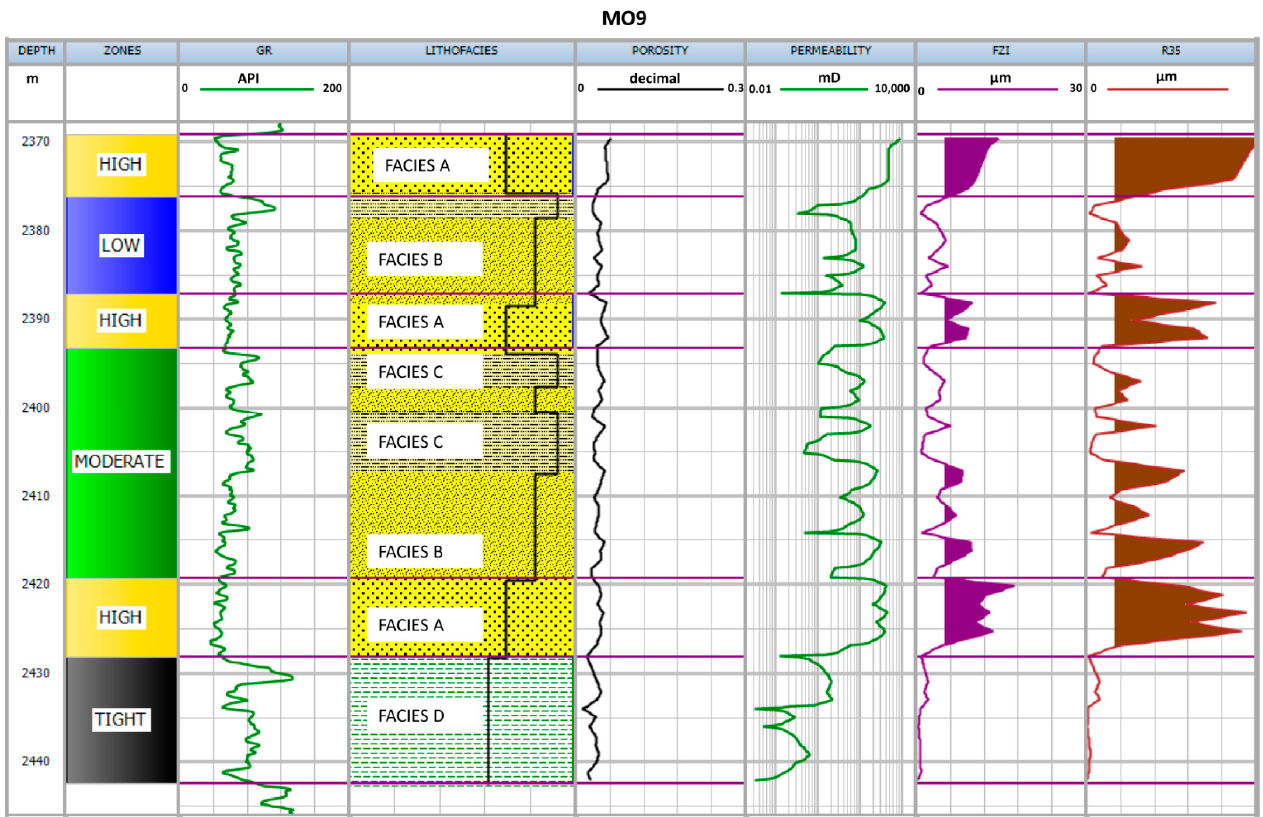
12 of 17 Figure 7. Results of well MO8 showing flow zones in track 2, gamma ray log in track 3, facies in track 4, porosity in track 5, permeability in track 6, FZI in track 7 and r35 in track 8. Six flow zones were identified in well MO9 (Figure 8). At the top of the reservoir is the high flow zone (2369.2–2376.2 m), Low (2376.2–2387.2 m), High (2387.3–2393.3 m), Moderate (2387.3–2419.3 m), High (2419.3–2428.2 m) and Tight (2428.2–2442.4 m) at the bottom of the reservoir. The high flow zones are generally associated with facies A. The high flow zone at the top of the reservoir is the best. It contributes 14% and 44% to storage and flow capacities, while the combinations of the other two high flow zones, the low zone and the moderate zone, contribute 70% and 55% to storage and flow capacities. Con ‐ versely, the tight flow zone interpreted as the lowest rock quality is associated with facies D, mainly silt and claystone ranked as an impervious reservoir rock type with 6% storage and 1% flow capacities. Flow zones are correlated to determine the lateral extent of the flow zones, as illus ‐ trated in Figure 9. Comparing flow zones between the studied wells indicates that the low